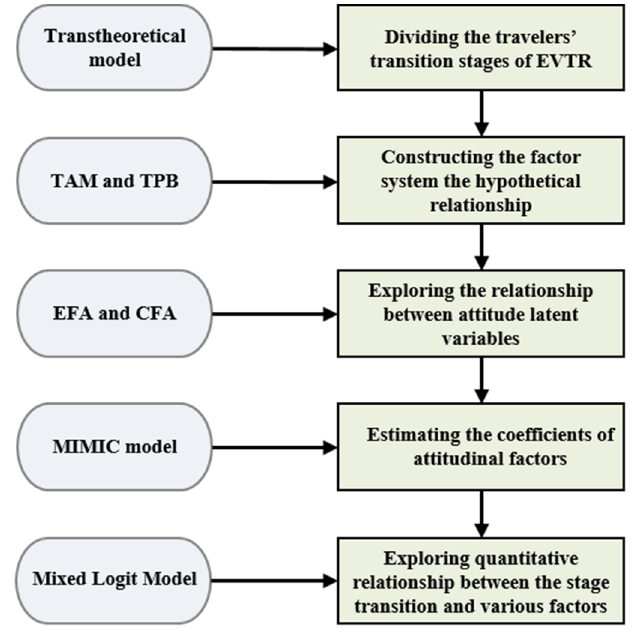
Figure 1. Overall framework.